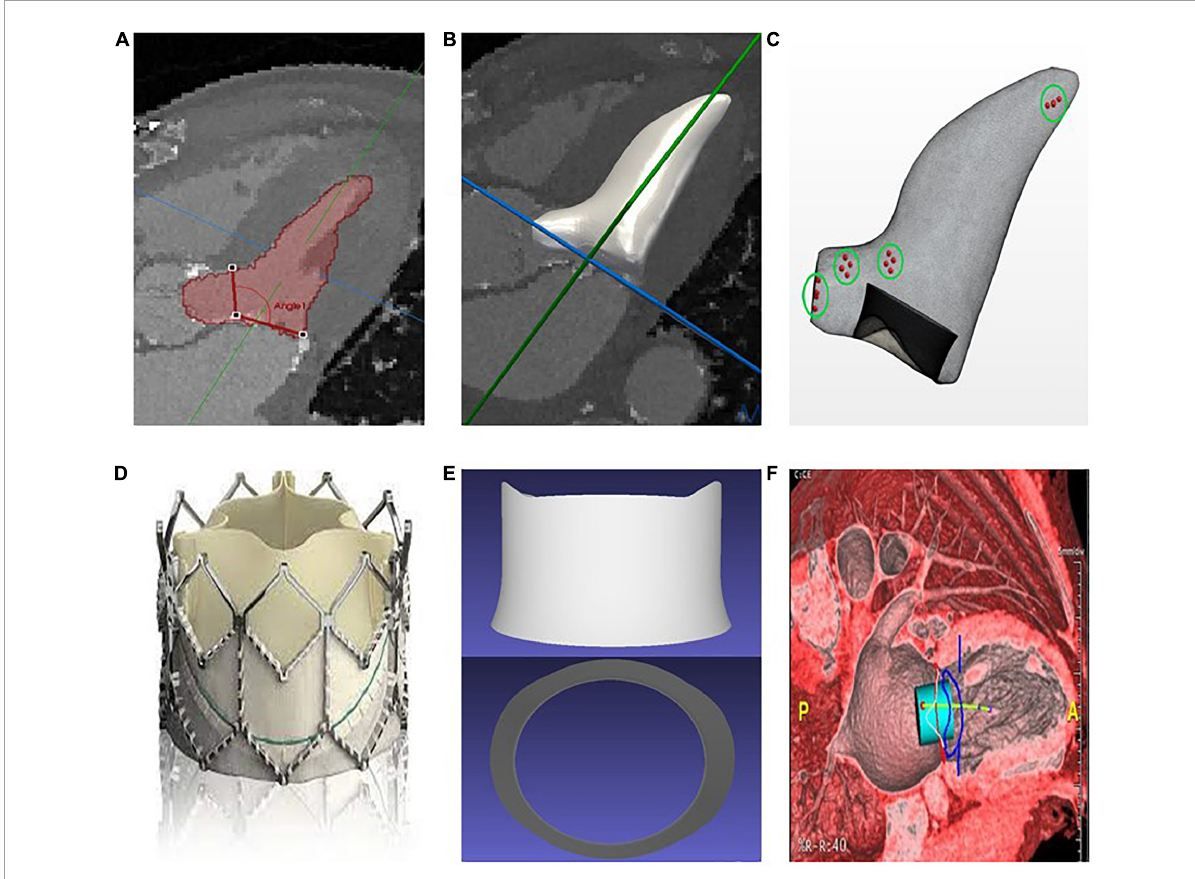
FIGURE1 (A) Manual segmentation of the left ventricle and measurement of the aortomitral angle. (B) Interpolation and smoothing of the segmented contours to a 3D surface. (C) Generation of a surface mesh, from which a volume mesh is generated (simulation domain); the points in the green circles represent the areas where the pressure is measured. (D) Sapien 3 bioprosthesis. (E) Simplified Computer-Aided Design (CAD) model of the Sapien 3 bioprosthesis. (F) Preprocedural assessment on CT data with a cylindrical valve overlaid to the images for neo-LVOT